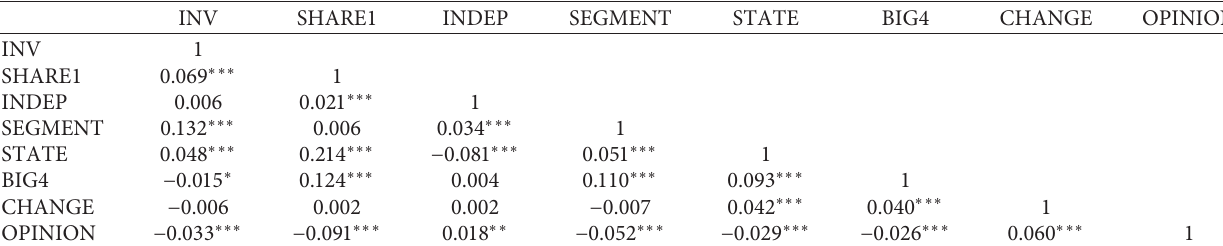
Table 5: Correlation coefficients